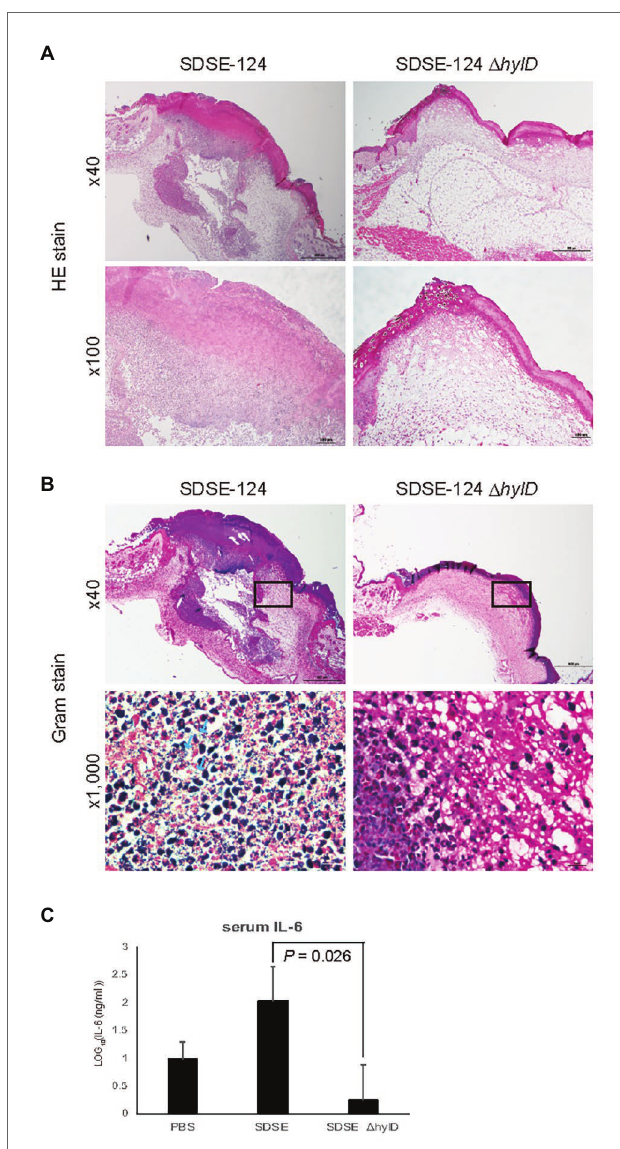
FIGURE 6 | Wound infection. (A) H&E staining and (B) Gram staining of tissue sections taken from the wound areas. An arrow indicates the bacteria cells. (C) IL-6 concentrations of SDSE-infected mice. Data represent the mean ± SD of log-transformation of IL-6 concentrations. Mice were infected with SDSE strains (1.4 × 10 6 CFU/mouse) via the wound areas. On day 2 after infection, the mice were euthanized with Sevofrane, blood was immediately collected for IL-6 tests, and samples of the wound areas were taken for H&E and Gram stains. The value of p was calculated using Student’s t